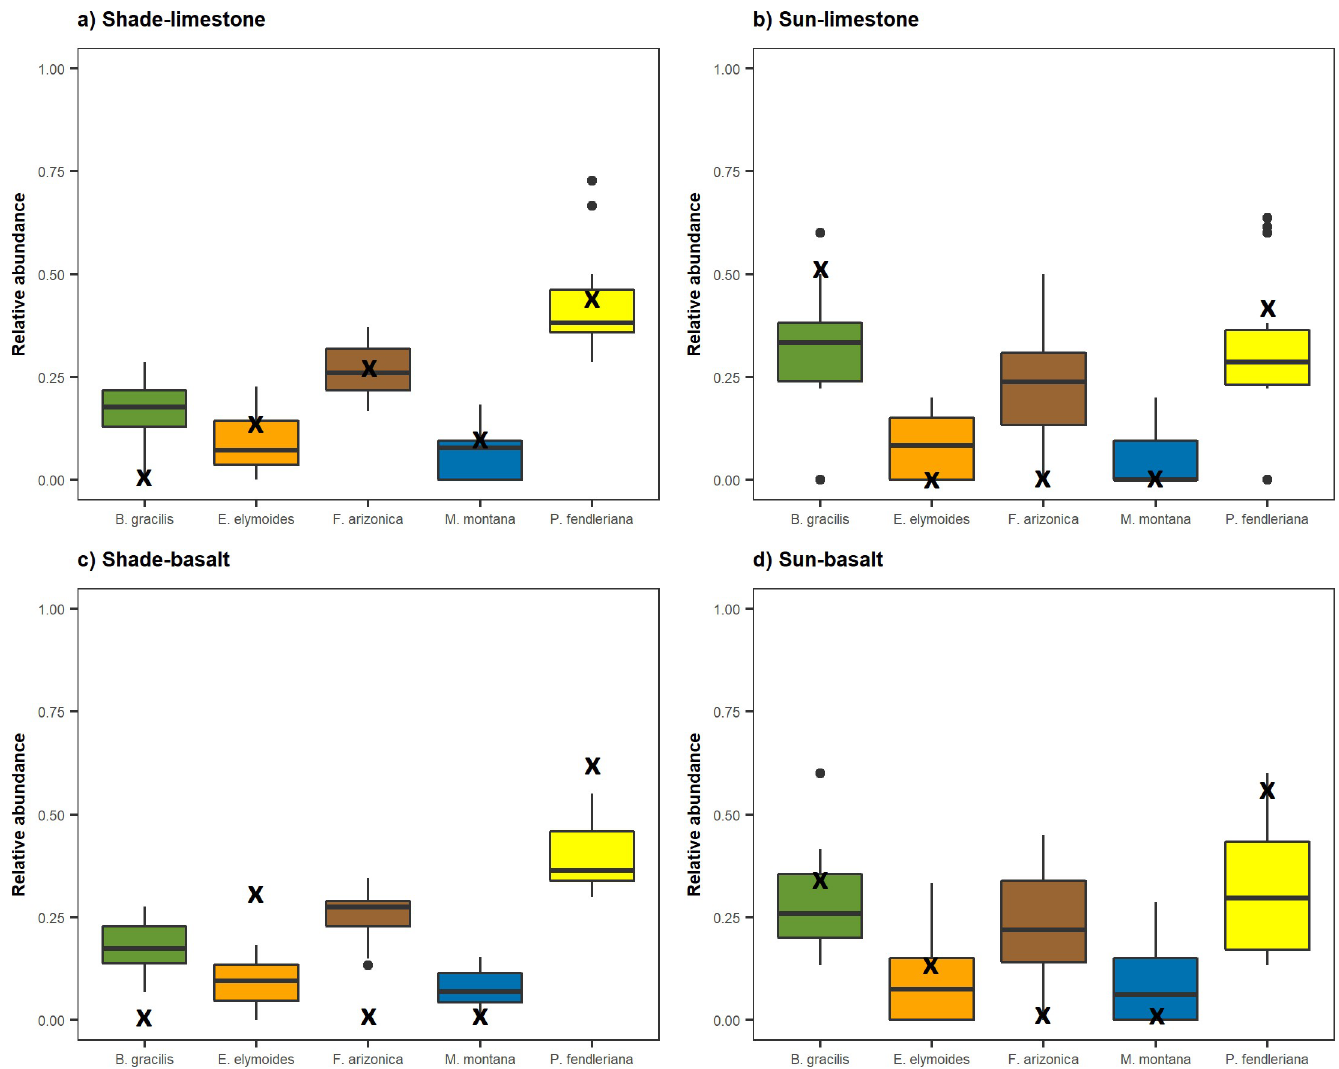
Fig 1. Distribution of observed (boxplots) and predicted ( x ) relative abundances of B . gracilis (green), E . elymoides (orange), F . arizonica (brown), M . montana (blue), and P . fendleriana (yellow) in four treatments based on parent material and light level; a) shade-limestone, b) sun-limestone, c) shade-basalt, and d) sun-basalt.